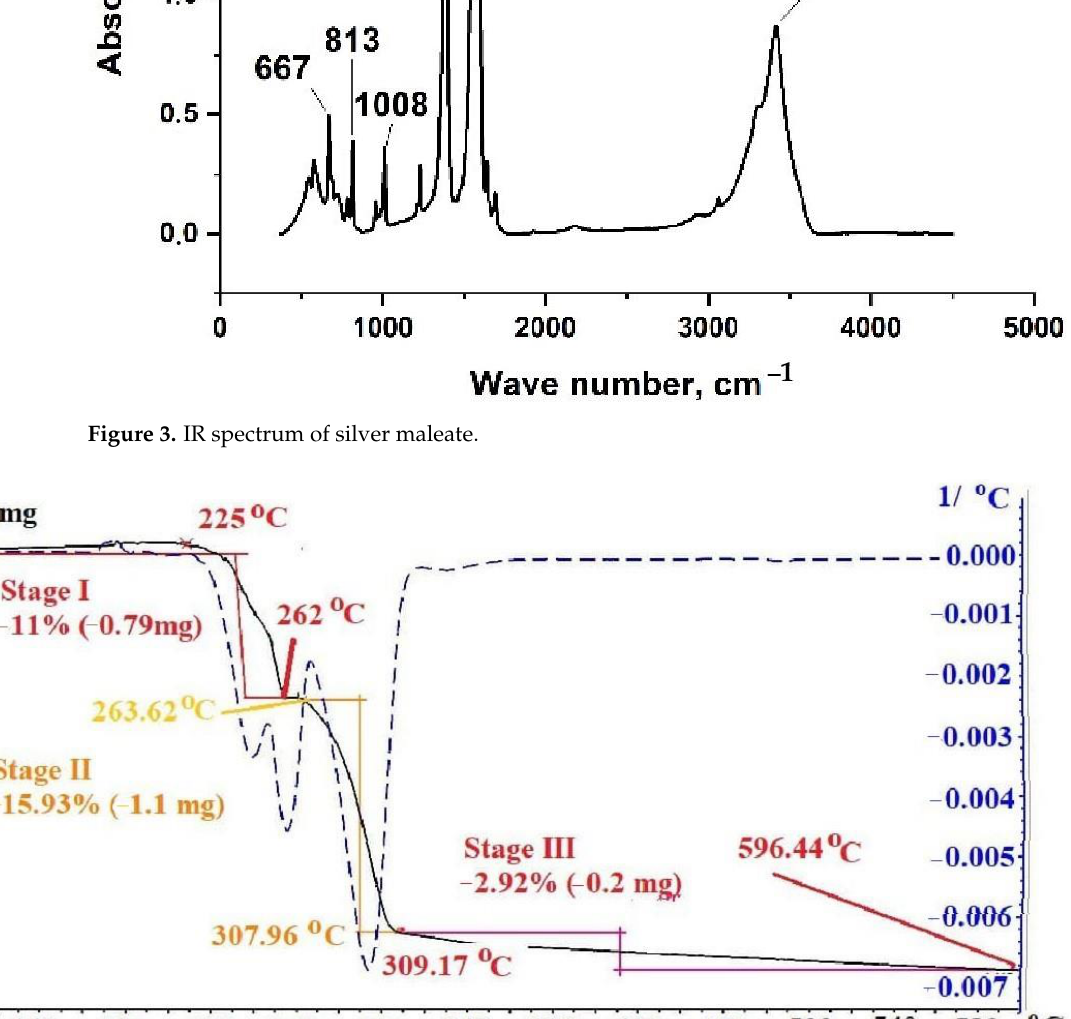
Figure 4. Thermogram of silver maleate.